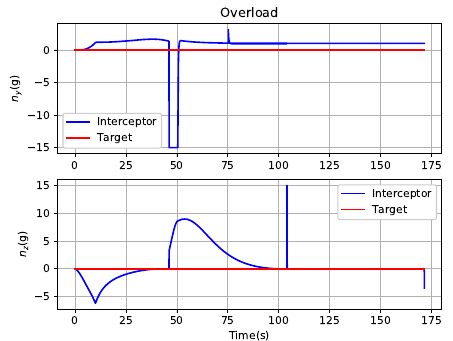
Figure 9. Overload of interceptor (target non-maneuvering).